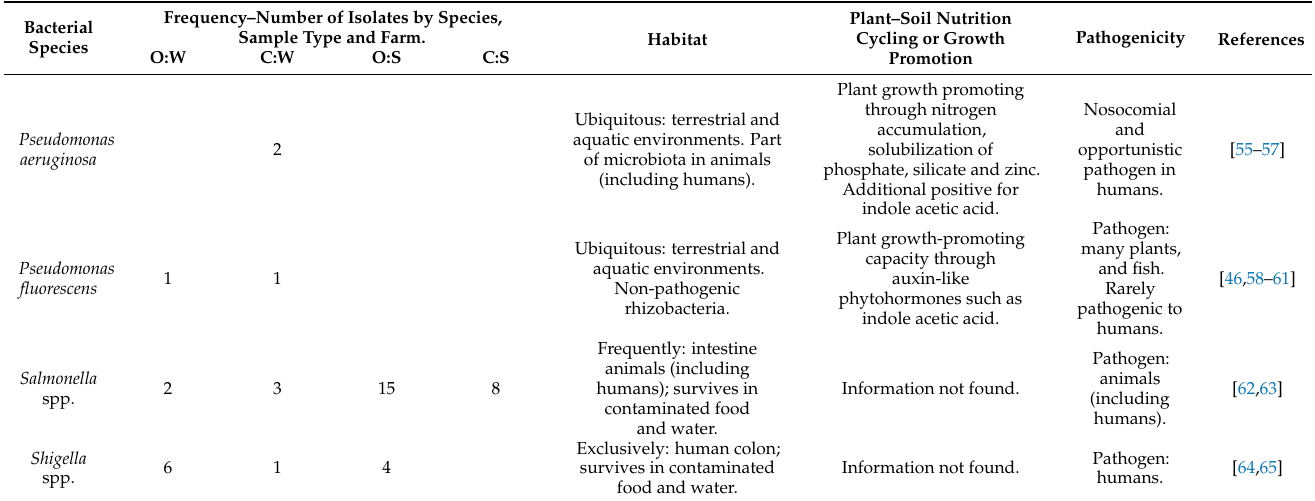
Figure 3. Bacterial richness according to sample type. Median richness (black horizontal bars); violin plots include the values within the min-max range; the width of the violin is proportional to kernel probability density of the data at different values. The NMDS analysis indicated an ordering between bacterial communities related to farm and sample type (Figure 4). This was corroborated via ANOSIM analysis, which pointed out significant differences between the two sample types ( r = 0.1131, p = 0.0027). Conversely, type of farm (organic and conventional sampling points) does not show significant differences ( r = 0.0427, p = 0.1004).